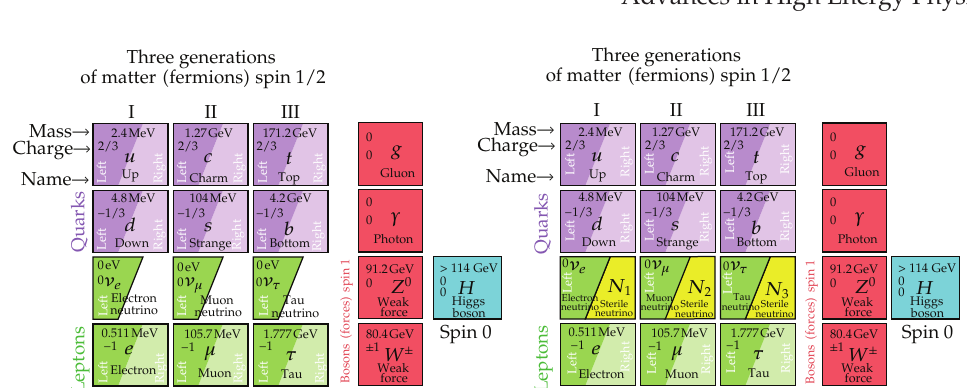
Figure 1: Particle content of the SM and its minimal extension in neutrino sector. In the SM (cid:2) left (cid:3) the right- handed partners of neutrinos are absent. In the ν MSM (cid:2) right (cid:3) all fermions have both left and right-handed components.